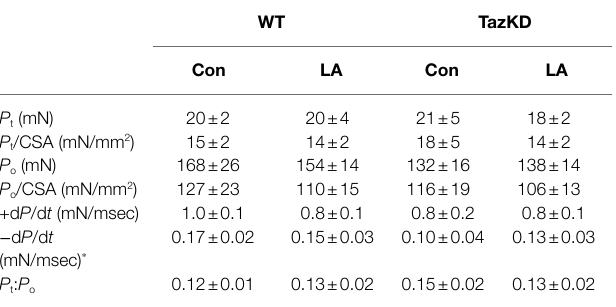
TABLE 2 | Isometric muscle function in response to 8 weeks of control or supplemental linoleic acid diet in soleus of doxycycline-induced tafazzin knockdown mice and their wild-type